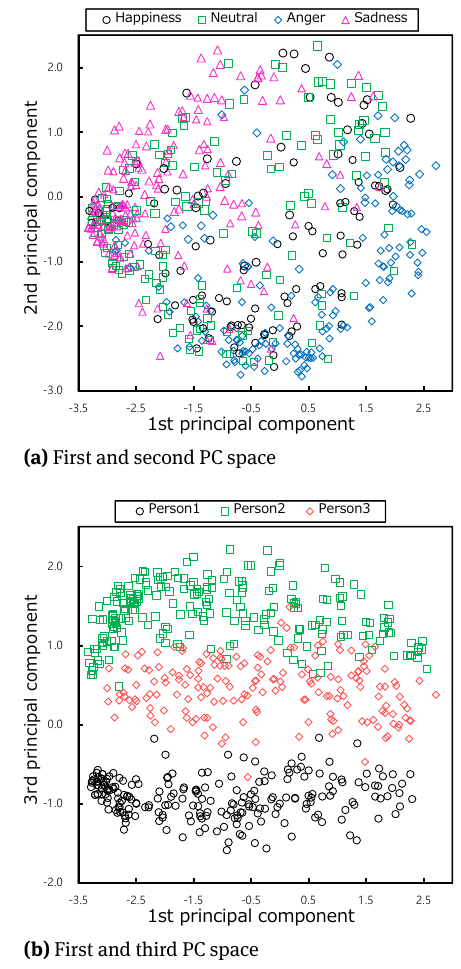
Figure 4: Principal component space of the acquired representation of multimodal signals in the highest hidden layer by self-organized learning in our model. (a) Each color and shape of the markers indi- cate the emotional state of interaction data (b) Each marker in the space corresponds to humans who expressed the